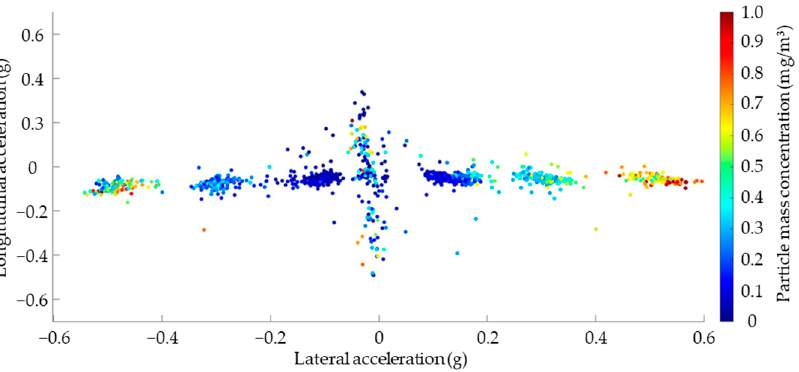
Figure 7. Correlation between longitudinal/lateral accelerations and emission of tire wear particles– test track.